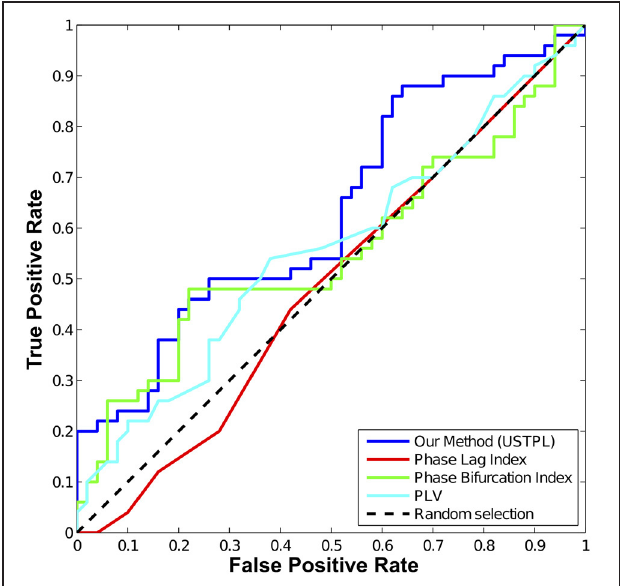
FIGURE 7 | ROC curve comparing the four statistics at a mean noise level equal to approximately 0.1% of the signal level, κ = 50, number of trials ( n ) = 20. USTPL (blue) has more detection power than PLV (cyan), PLI (red), and PBI (green).